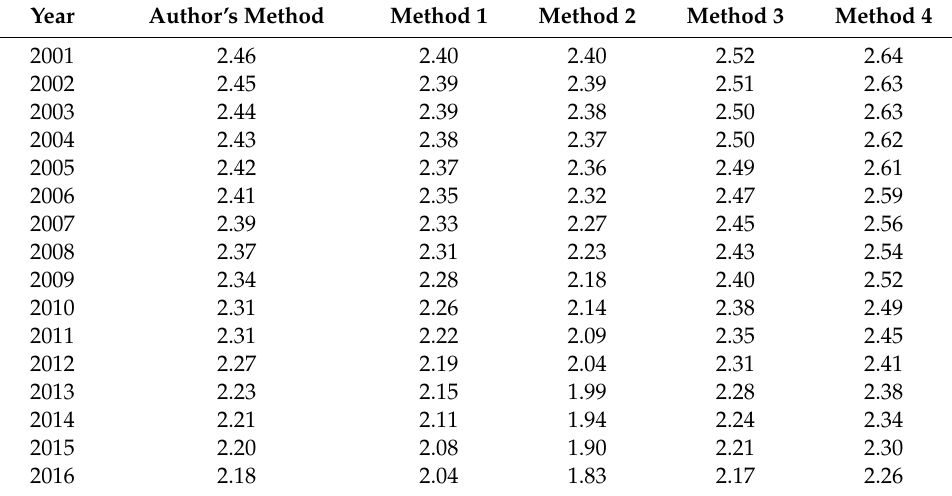
Table 3. Primary PEF energy indicators in the present area of the European Union in 2001–2016—a comparison of the author’s original method with the methods proposed by the